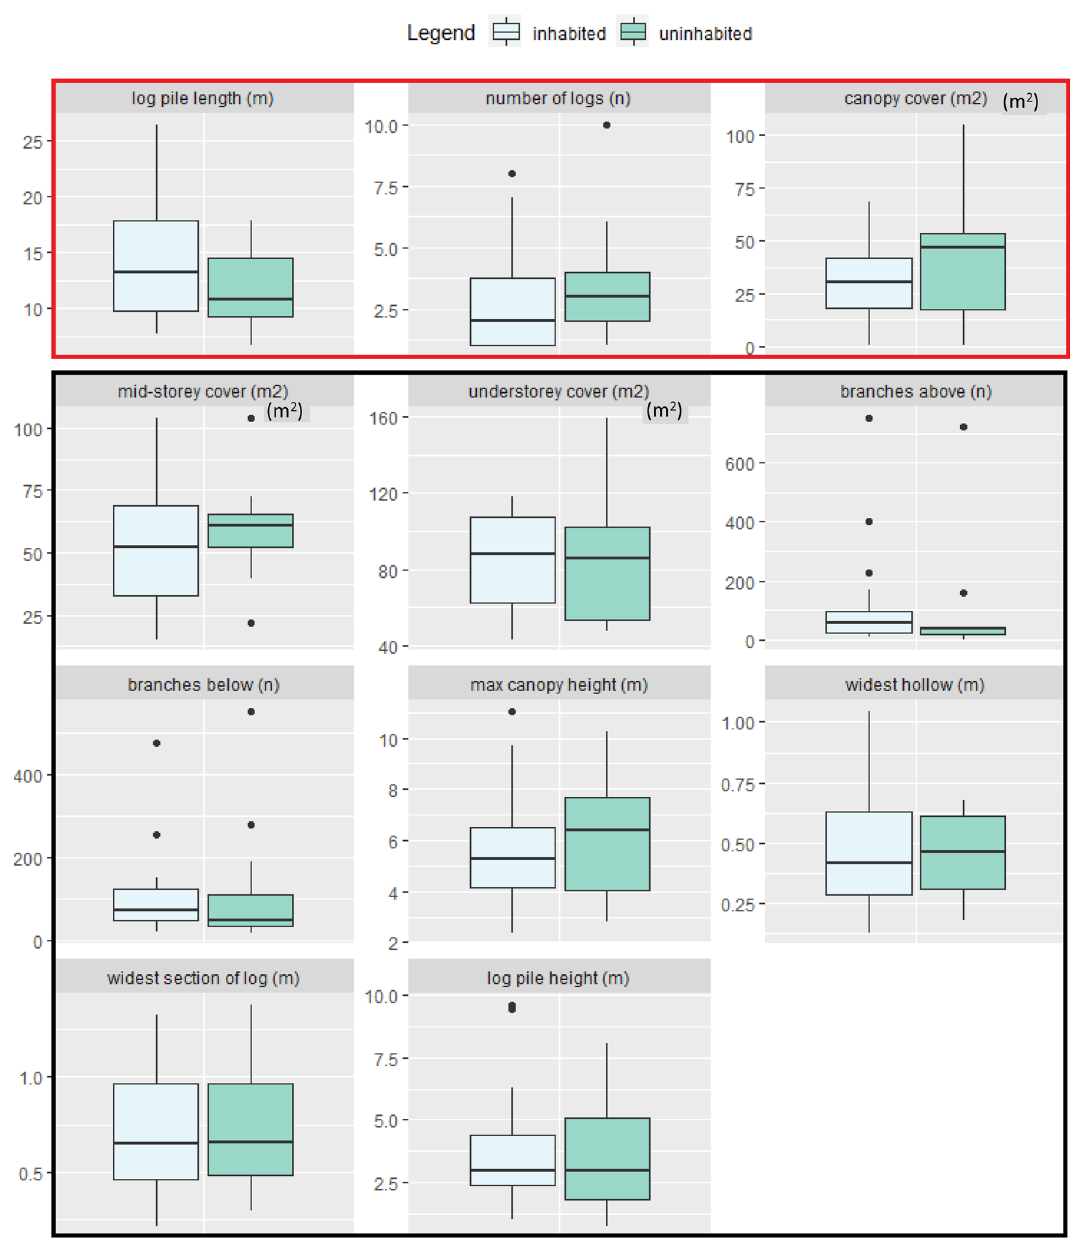
Figure 4. Boxplots showing the average log pile characteristics at both inhabited and uninhabited log piles. Thick horizontal lines indicate the median, boxes represent the 2nd and 3rd quartiles, and whiskers represent the 1st and 4th quartiles. Individual points represent outliers. Variables well supported to influence log pile occupancy (log pile length, number of logs and canopy cover) are bordered in